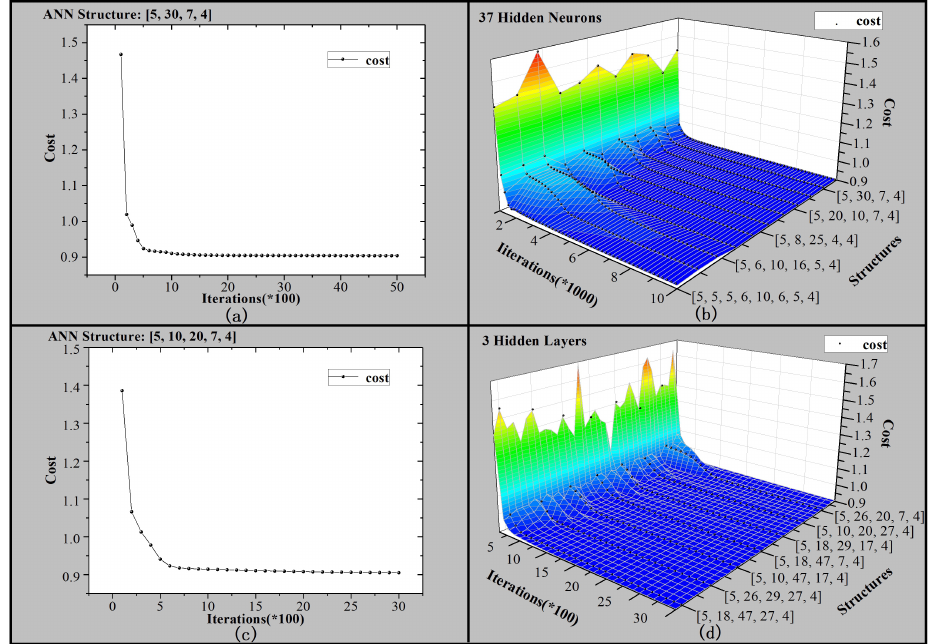
Figure 5. Relationship between costs, iterations and structures of the gas neural networks: ( a ) ANN structure is [5, 30, 7, 4]. ( b ) Different ANN structures with 37 hidden neurons. ( c ) ANN structure is [5, 10, 20, 7, 4]. ( d ) Different ANN structures with 3 hidden